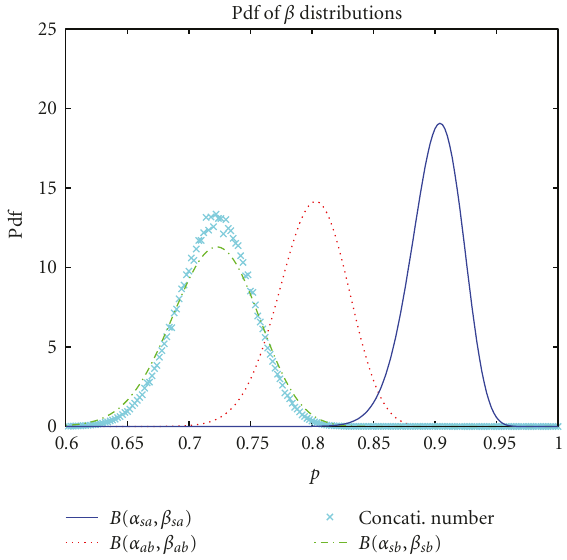
Figure 2: Link quality